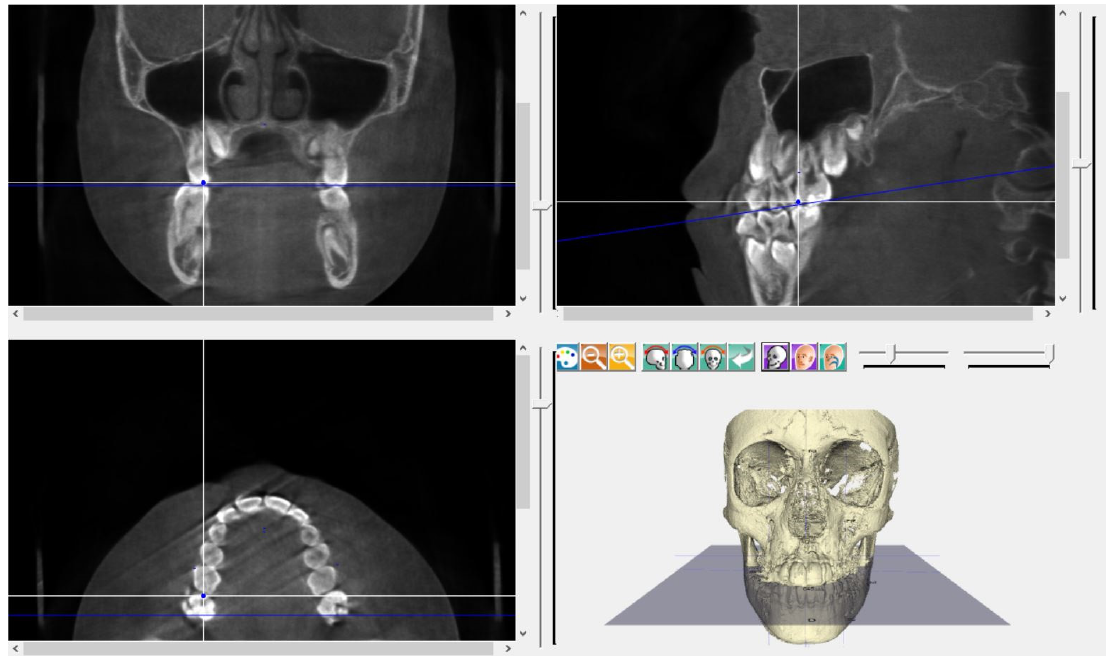
Figure 2. 3D rendering and vertical, transverse and sagittal projections provided by Delta-Dent soft- ware.